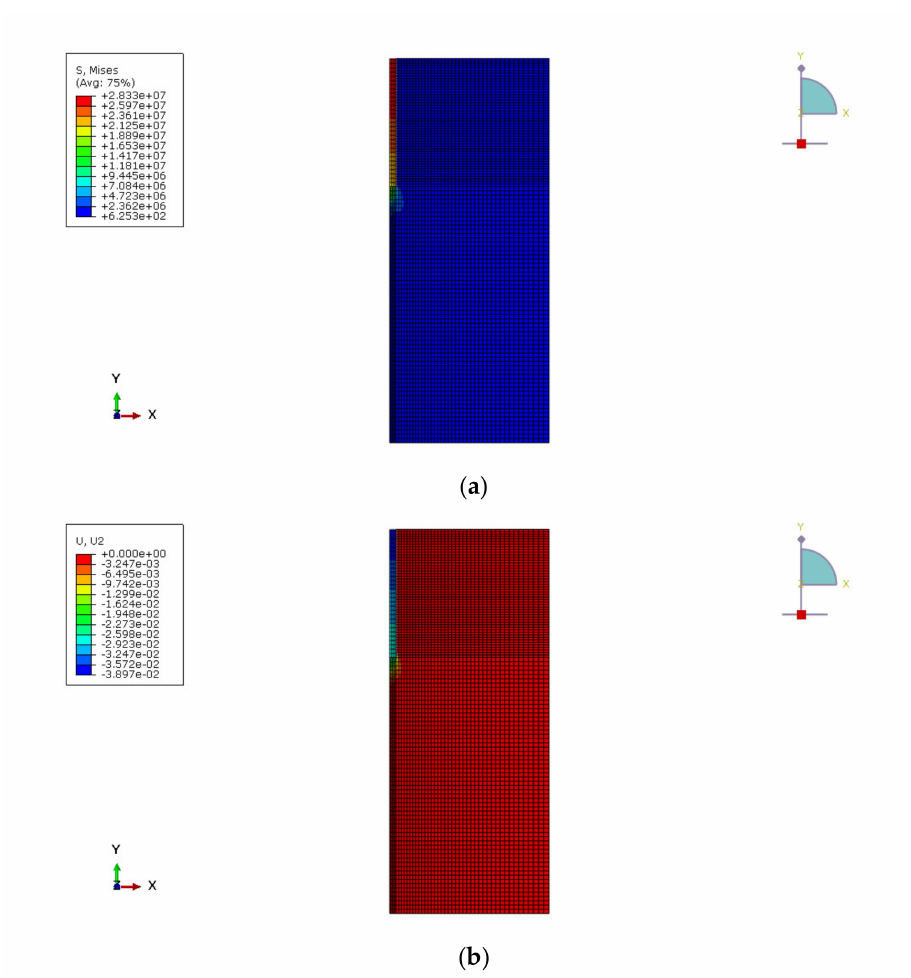
Figure 8. ( a ) The equivalent stress distribution of the pile-rock stratum model; ( b ) the deformation of the pile-rock stratum model.